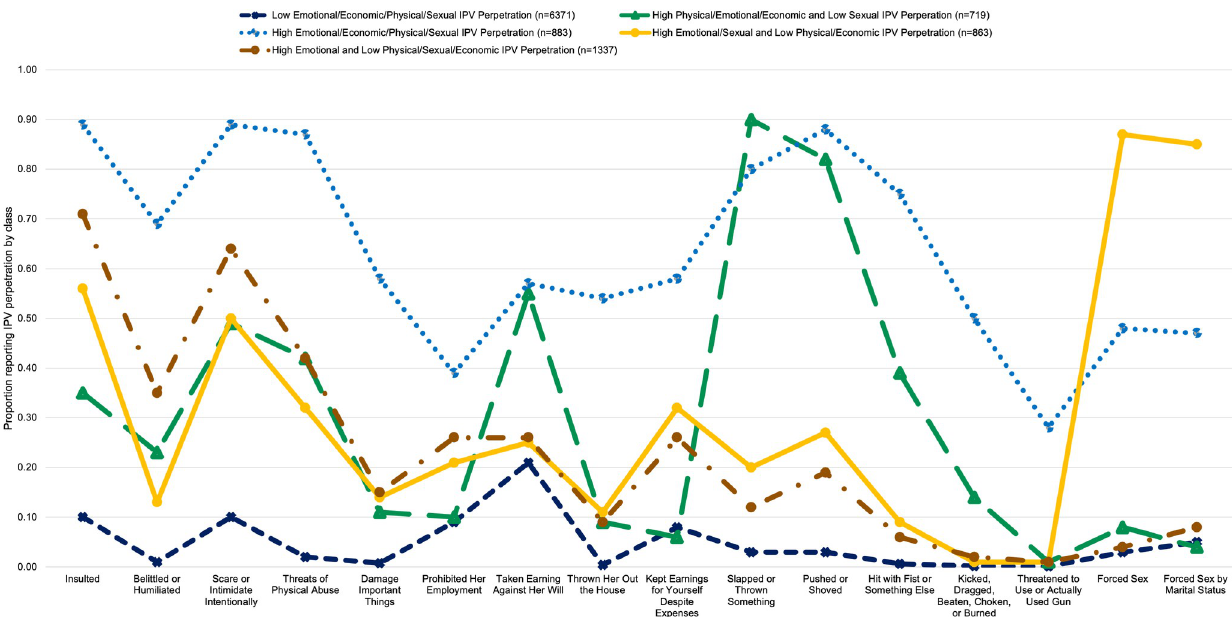
Fig 1. Probability of reporting each IPV perpetration behavior by latent